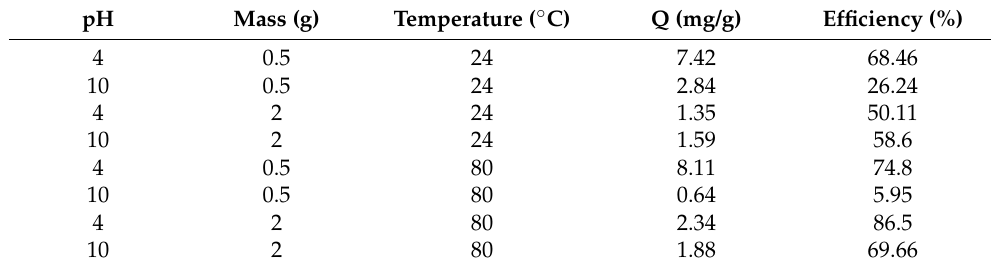
Table 4. Results of factorial design in terms of capacity and removal efficiency of BR dye onto ALP.